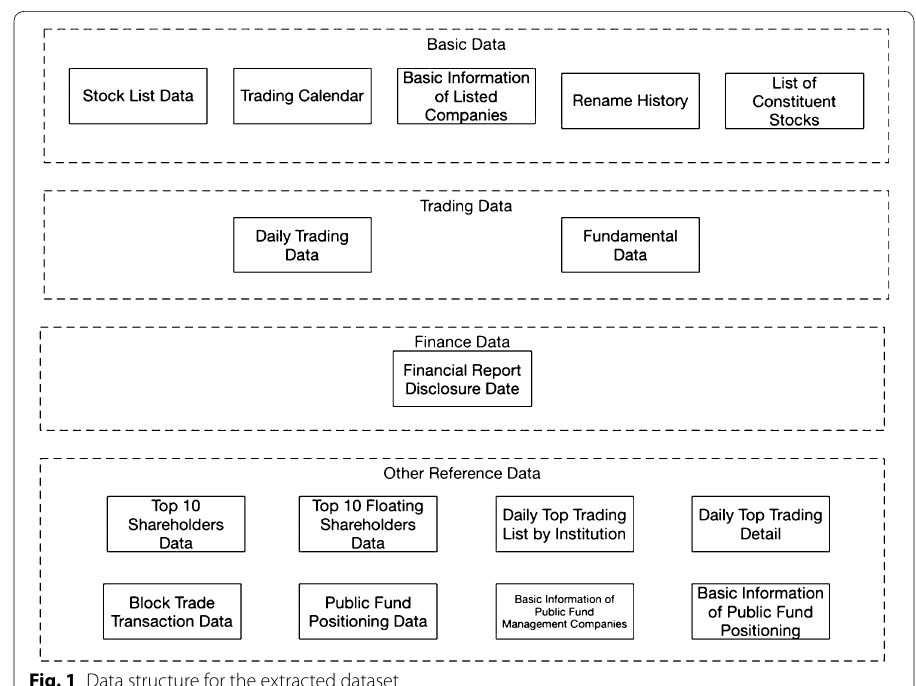
Fig. 1 Data structure for the extracted